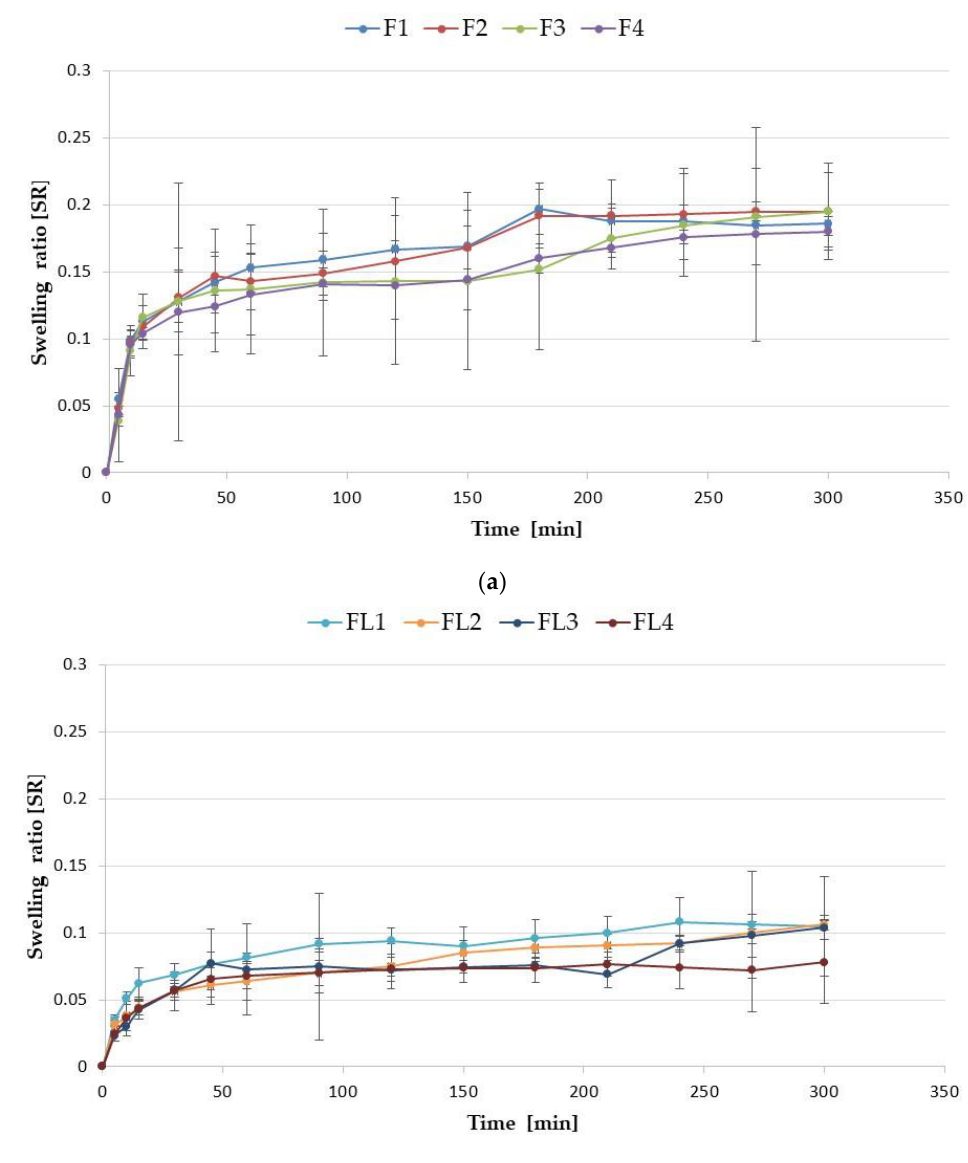
Figure 6. Swelling ratio of (a) placebo (F1 – F4) and (b) LUL-loaded (FL1 – FL4) microparticles in SVF at pH 4.2 (mean ± SD, n =